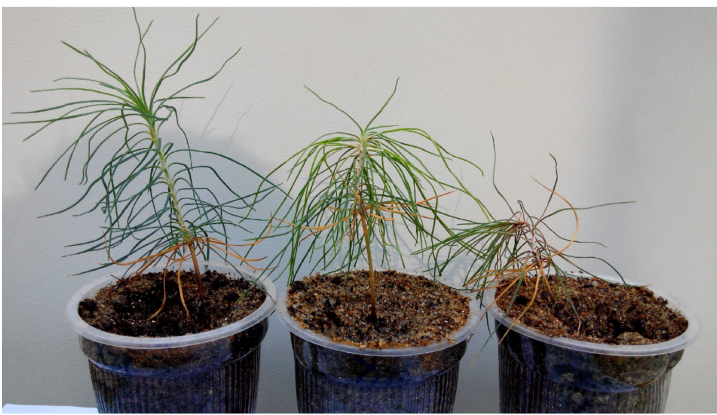
Figure 1. Healthy, wilting, and dead Pinus tabulaeformis Carr. seedlings growing in the